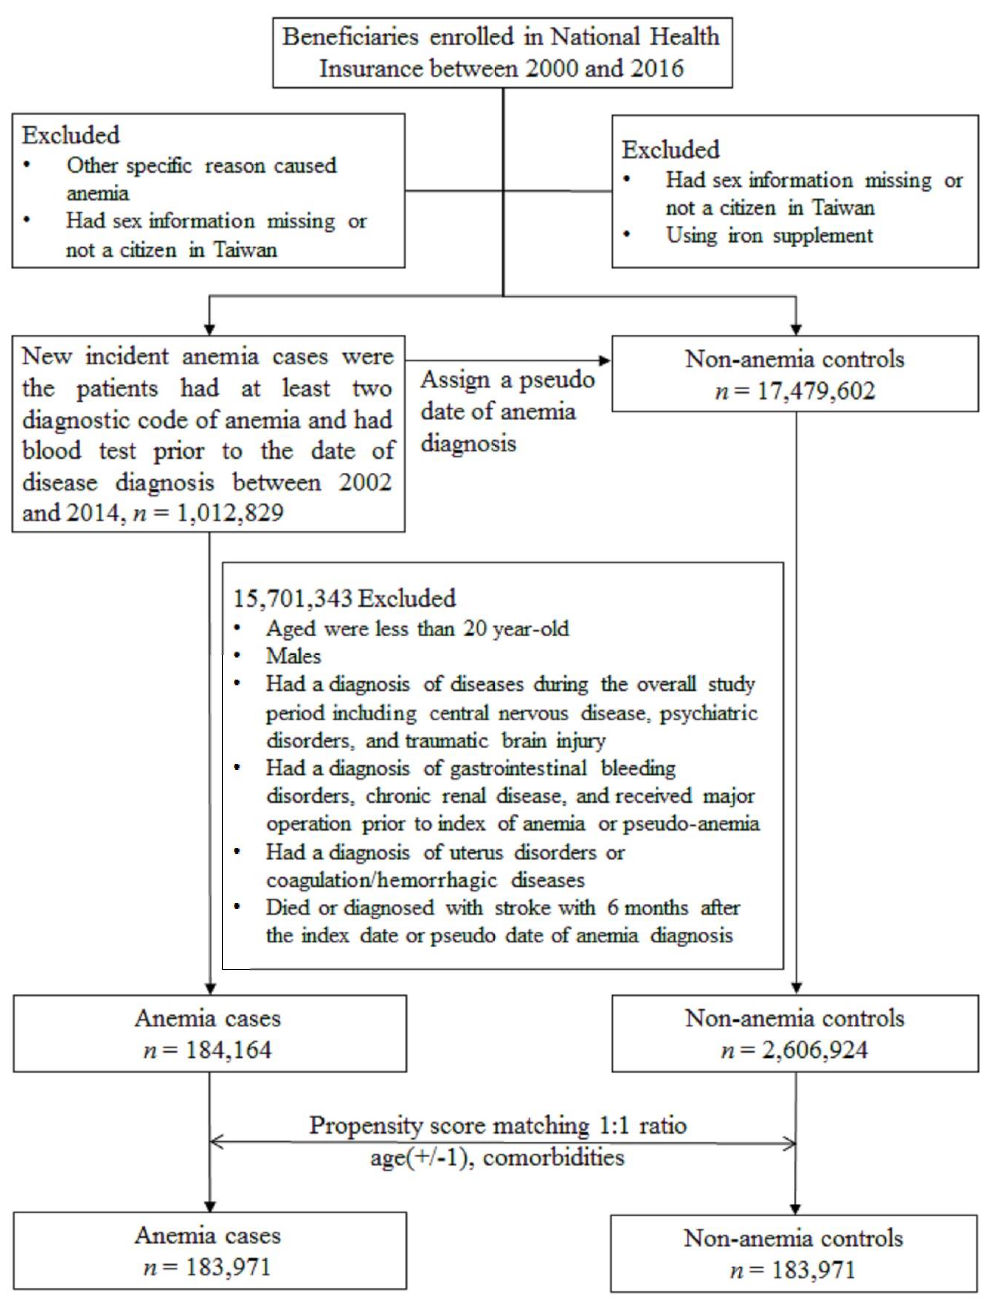
Figure 1. Patient selection flowchart.